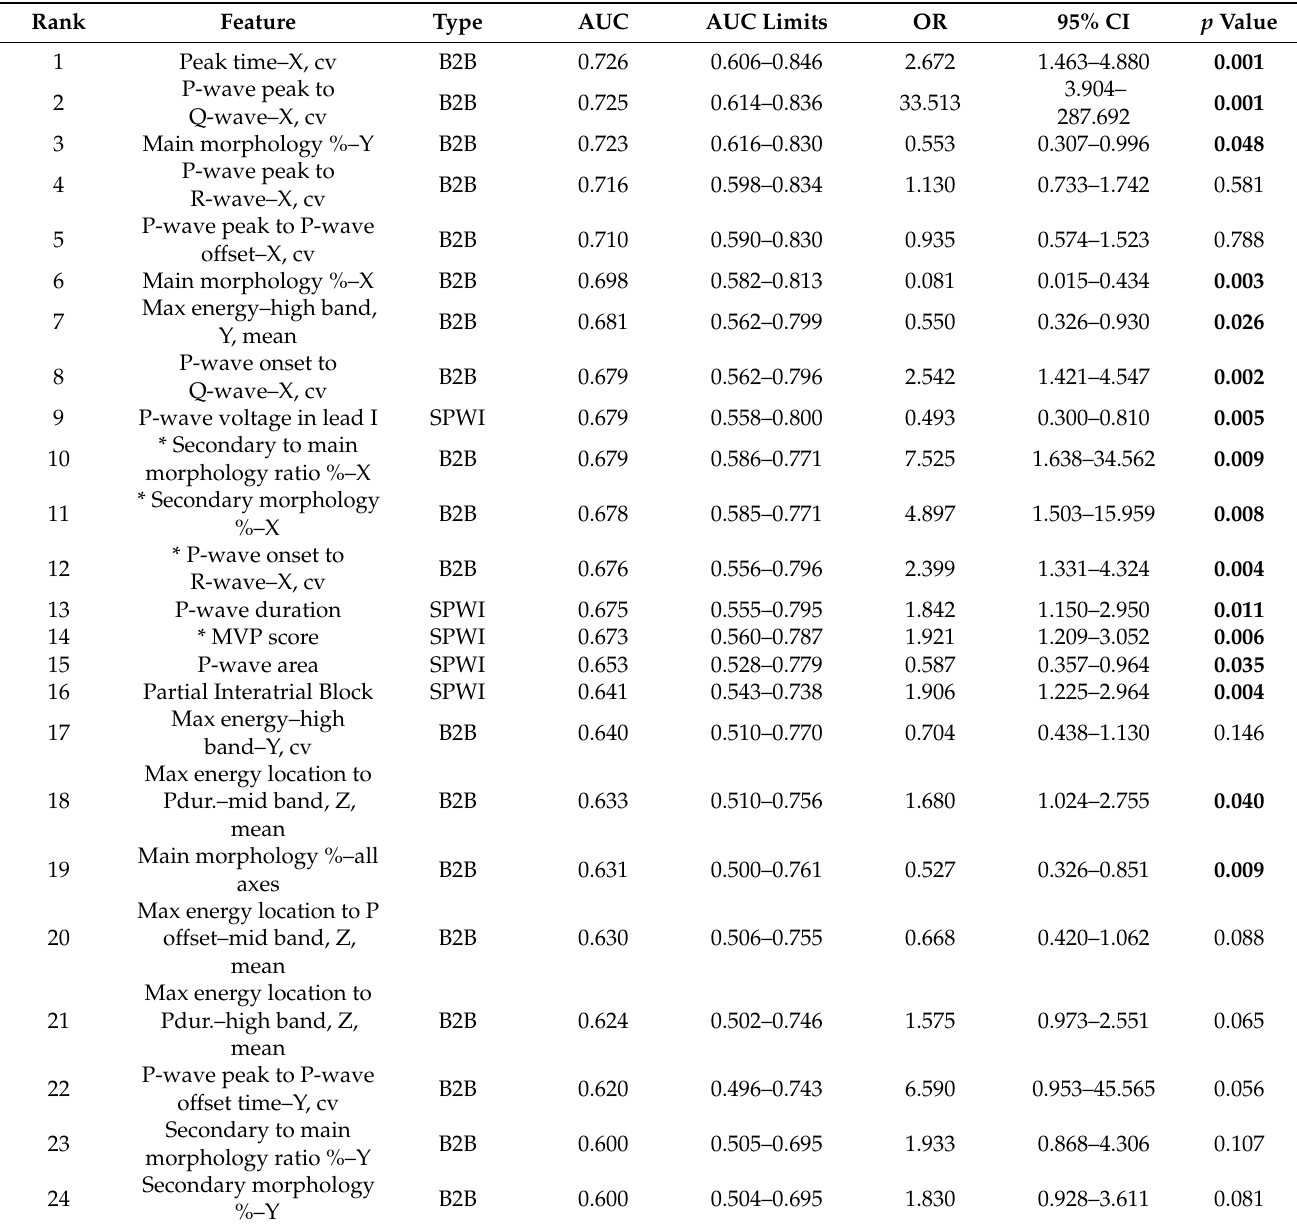
Table 4. Univariate regression analysis of potential prognostic factors on the presence of atrial